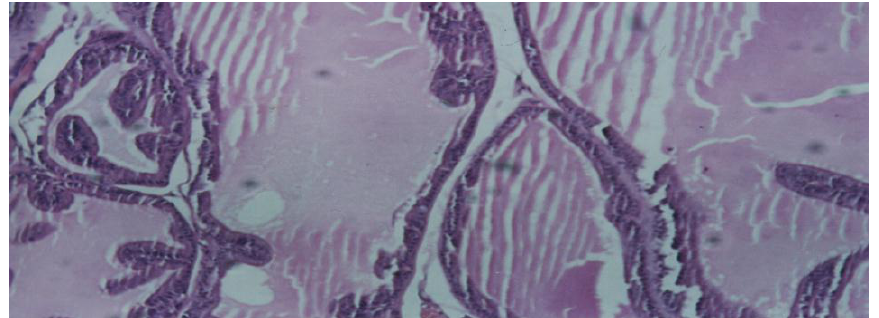
Figure – 6: Cross section from prostate of castrated treated rat showing the highest of secretory cells and more fluid in the lumen ( H&E stain,